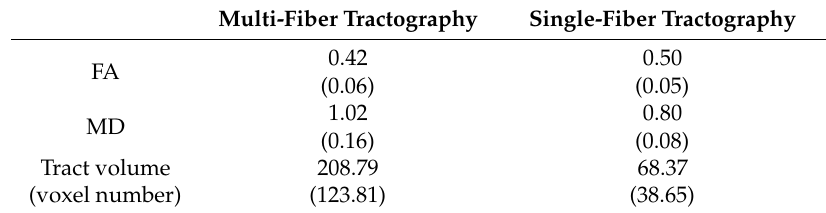
Table 2. Di ff usion tensor imaging (DTI) parameters of medial longitudinal fasciculus according to type of DTI tractography.